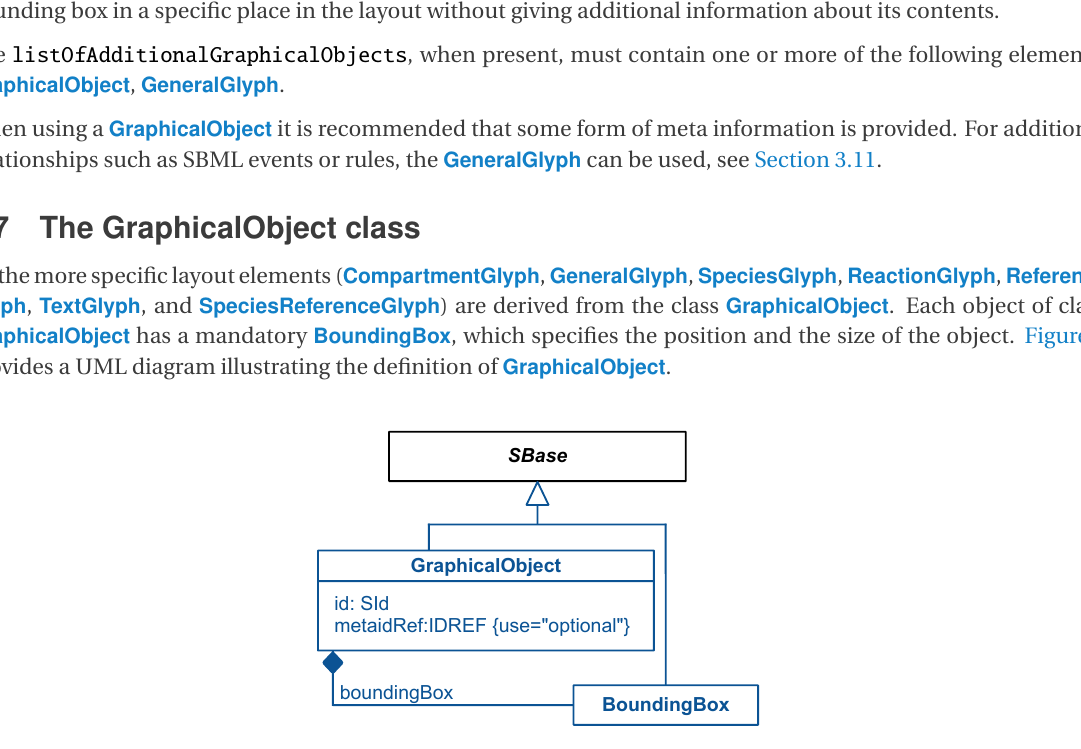
Figure 9: The definitions of the GraphicalObject